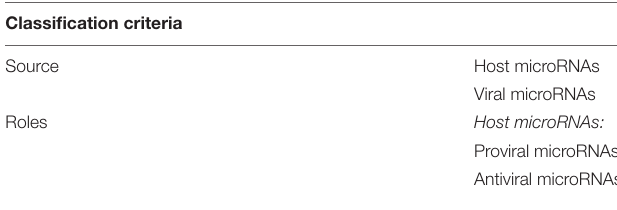
TABLE 1 | Classification of microRNAs based on their source and roles. Classification criteria Source Host